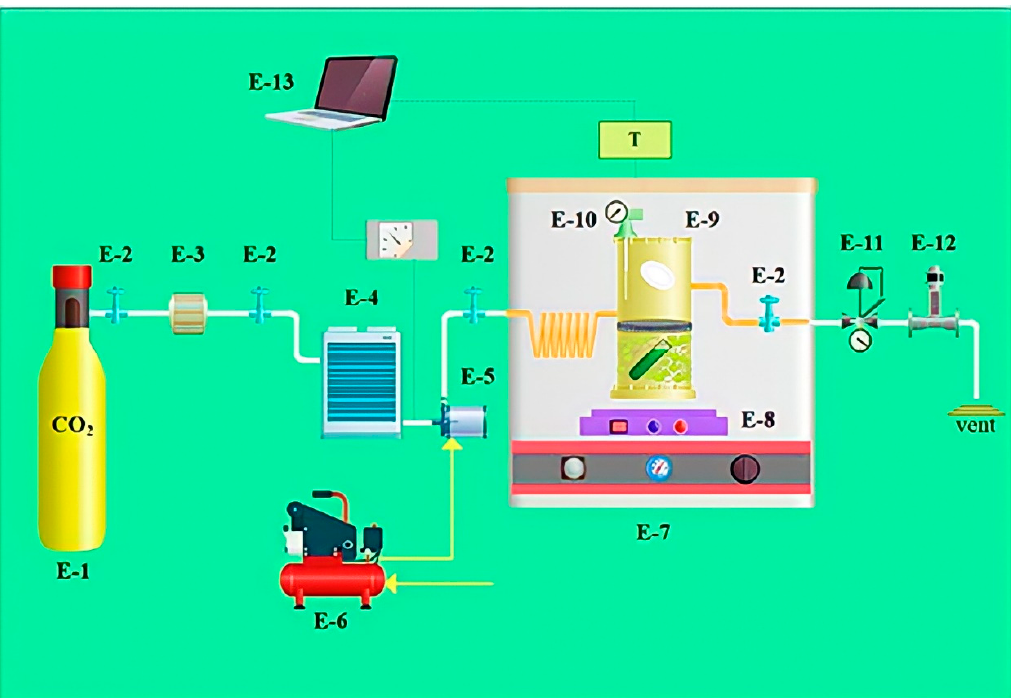
Figure 2. Schematic representation of the SC-CO 2 -assisted impregnation apparatus. E-1: CO 2 cylin- der; E-2: Needle valve; E-3: Filter; E-4: Refrigerator unit; E-5 High pressure pump; E-6: Compressor; E-7: Oven; E-8: Magnetic stirrer; E-9: Impregnation cell; E-10: Pressure gauge; E-11: Micro metered valve; E-12: Back pressure; E-13: Automation.